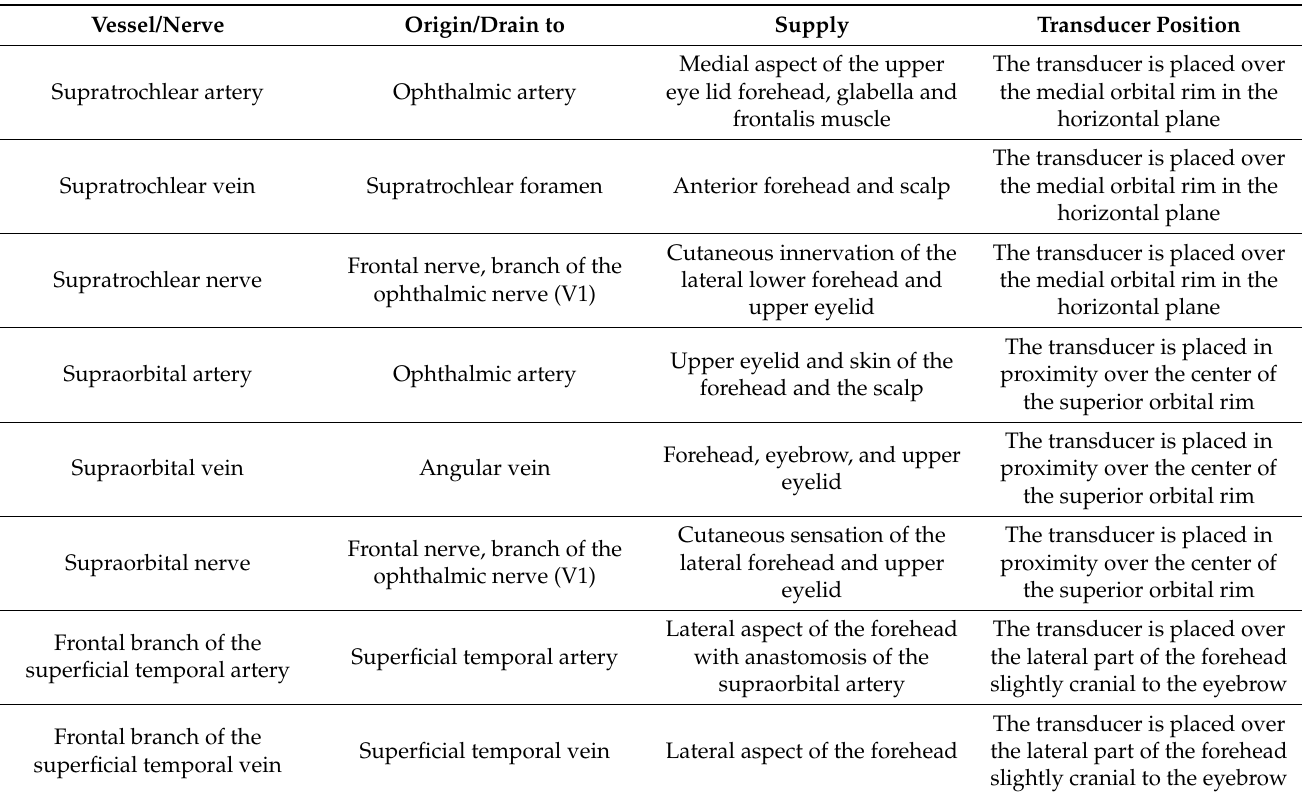
Table 1. Summary of the anatomy and scanning techniques for the neurovascular structures of the upper face.